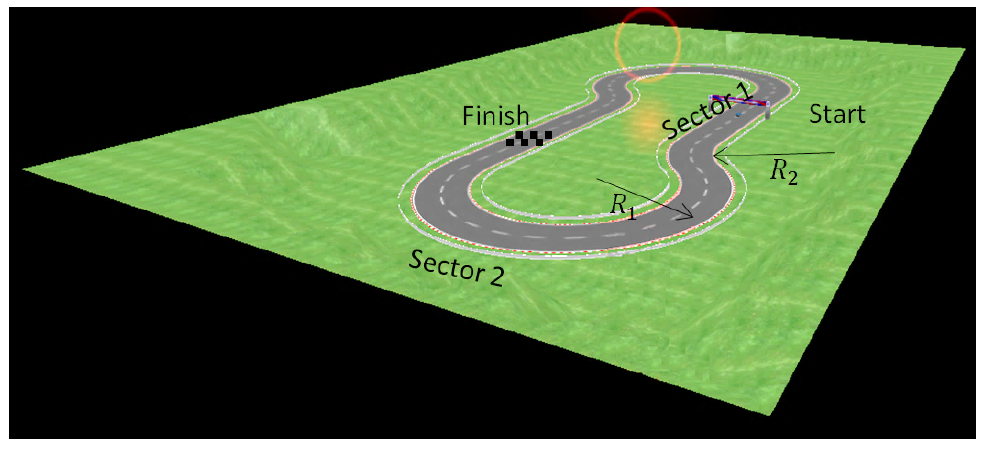
Figure 2. Hook-type test track.